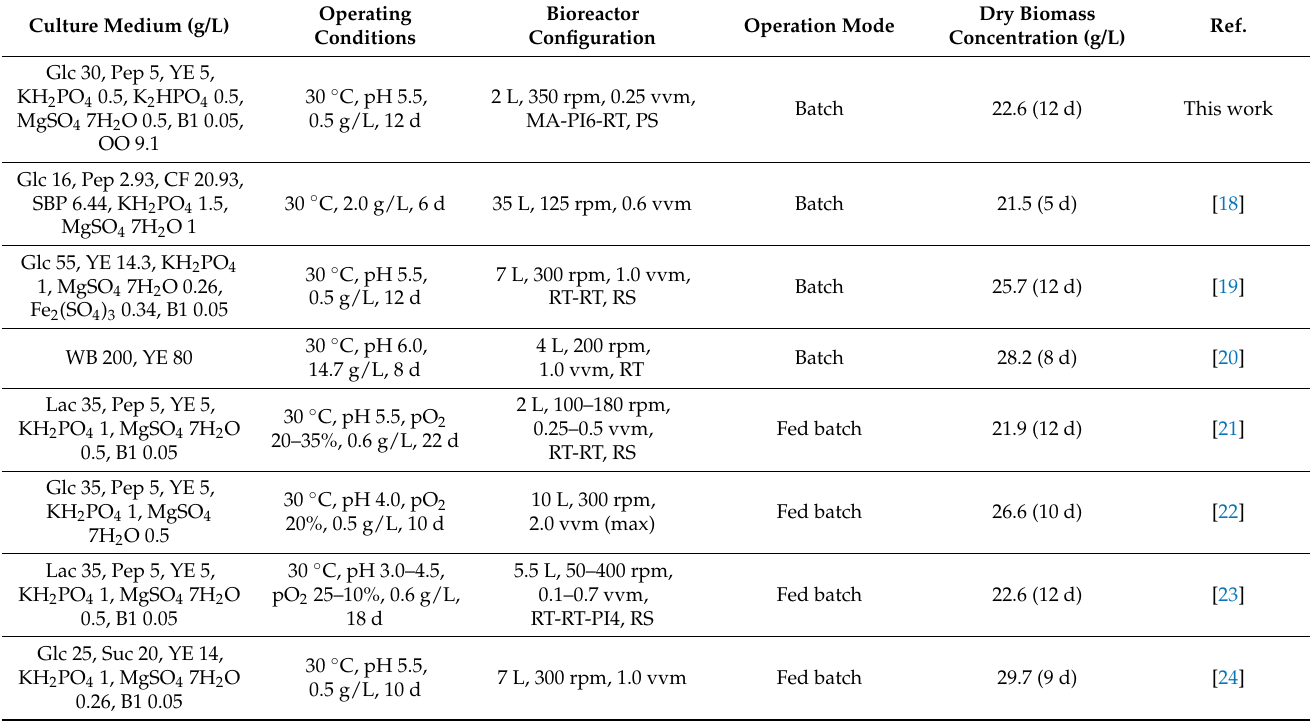
Table 7. Reported dry biomass concentrations and culture conditions for Ganoderma sp. growth in stirred tank